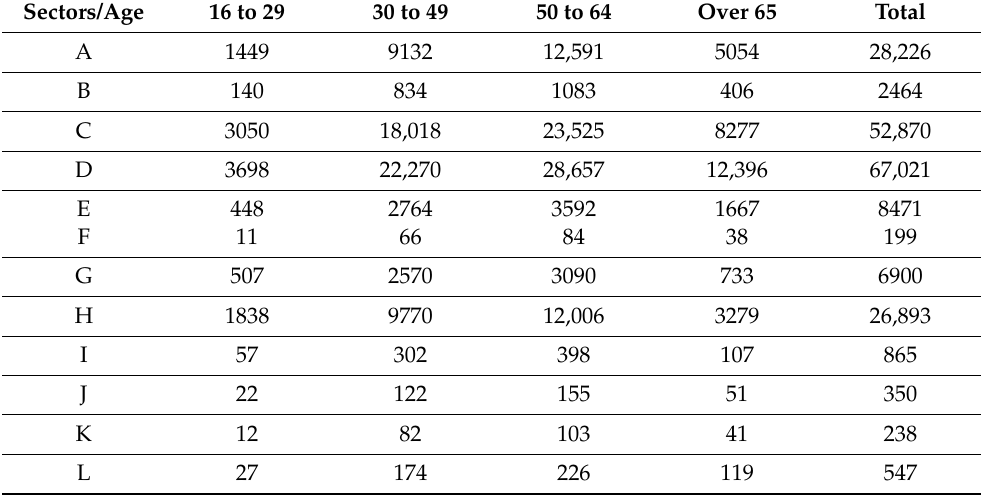
Table A1. CO 2 emissions associated with household consumption by age bracket and productive sector for 2005 (thousands of tons of CO 2